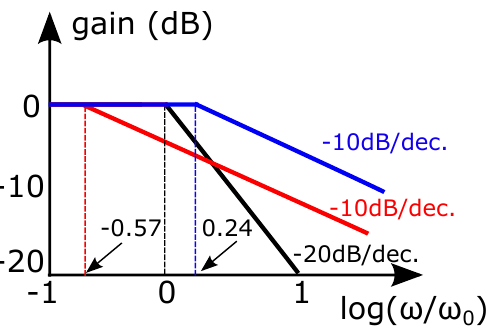
Figure 1. Bode plots of fractional-order (red) and power-law (blue) low-pass filters of order α = β = 0.5, and their integer-order mother function